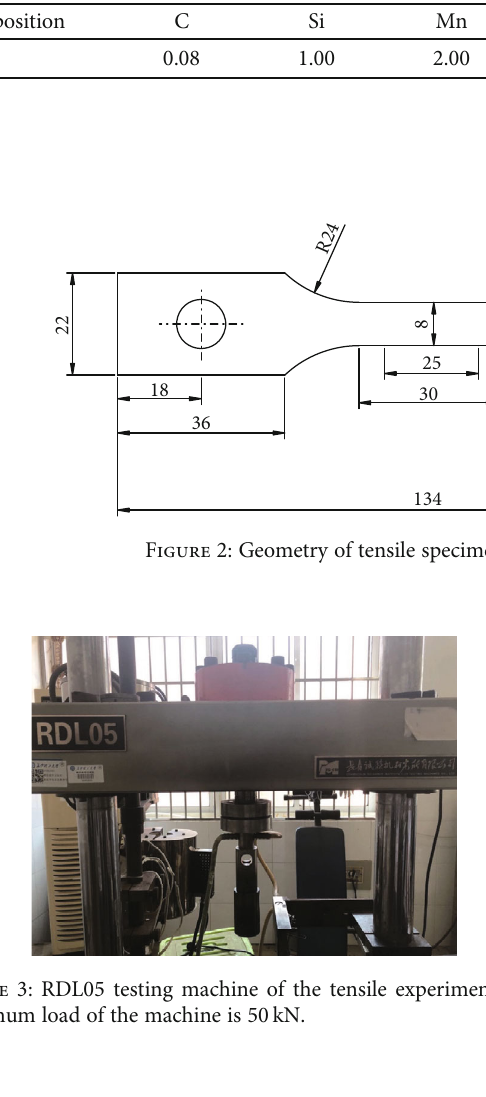
Table 1: Chemical compositions (wt.%) of 321 stainless steel.